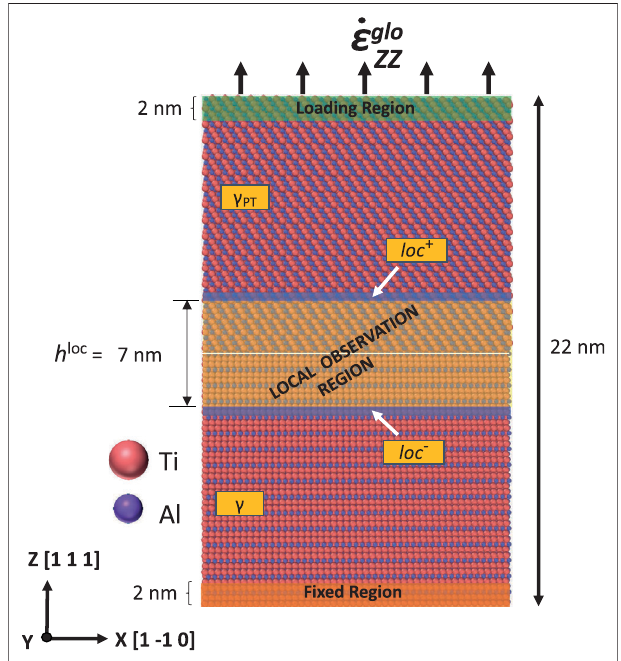
FIGURE 3 | In the loading region (top/green), a constant velocity is prescribed in the Z-direction for all atoms. In the fi xed region (bottom/orange), atomsarekept fi xedattheirposition.Inthemobileregion(thewholerestofthe simulationdomain),nospeci fi cpositionorvelocity wasprescribed, buta local observation region with a height h loc is de fi ned in order to evaluate the local separation